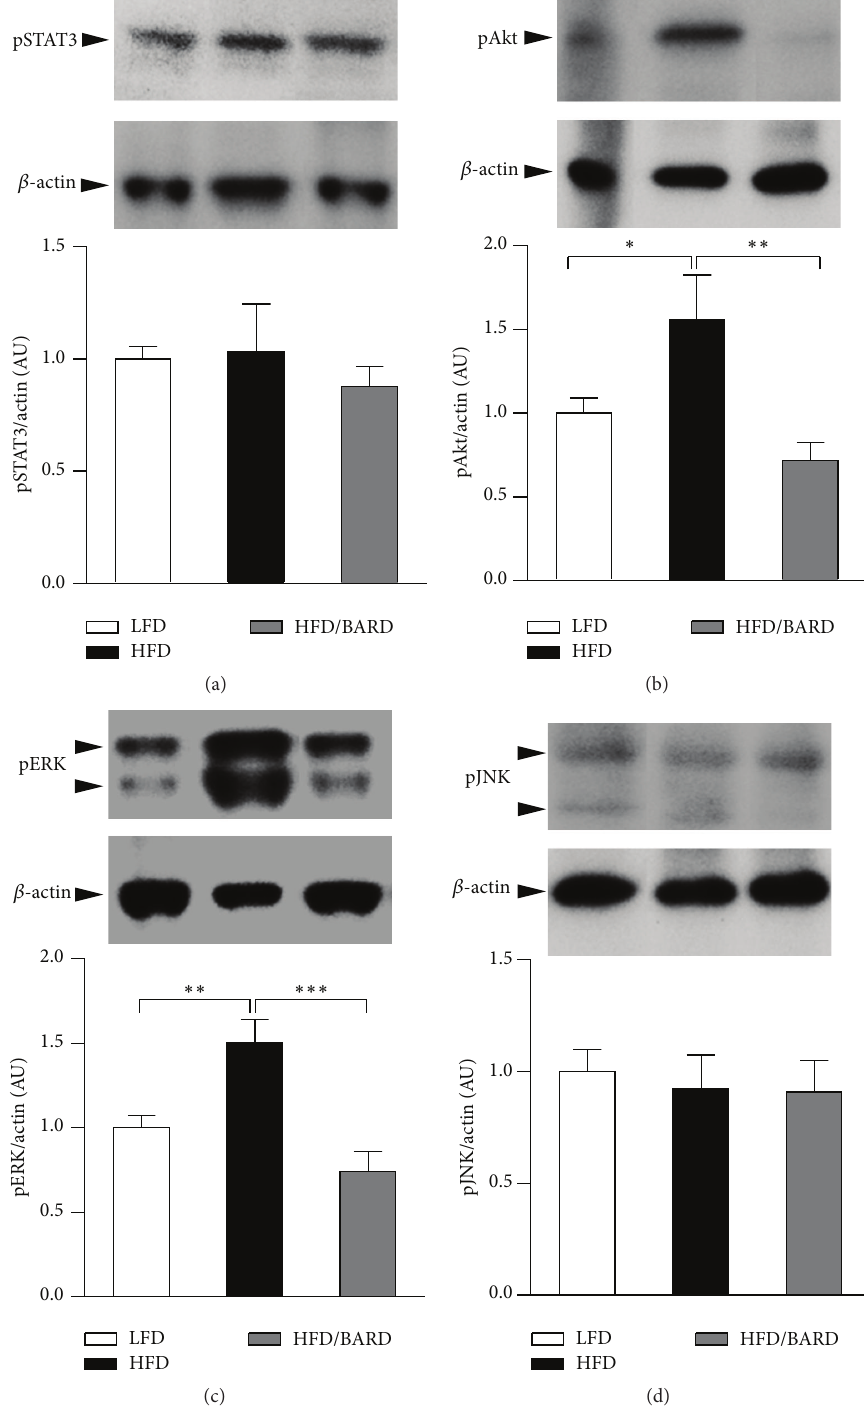
Figure 4: Effect of bardoxolone methyl (BARD) on expression of stress activated proteins in mesenteric fat tissue of mice fed low-fat diet (LFD), high-fat diet (HFD), and high-fat diet supplemented with BARD (HFD/BARD). (a) Representative blots and protein level of pSTAT3. (b) Representative blots and protein level of pAkt. (c) Representative blots and protein level of pERK. (d) Representative blots and protein level of pJNK. All data are expressed as mean ± SEM. ∗ 𝑝 < 0.05 ; ∗∗ 𝑝 < 0.01 ; ∗∗∗ 𝑝 < 0.001 . pSTAT3: phosphorylated signal transducer and activator of transcription 3, pAkt: phosphorylated protein kinase B, pERK: phosphorylated extracellular signal-regulated kinase, pJNK: phosphorylated c-Jun N-terminal kinase, and AU: arbitrary